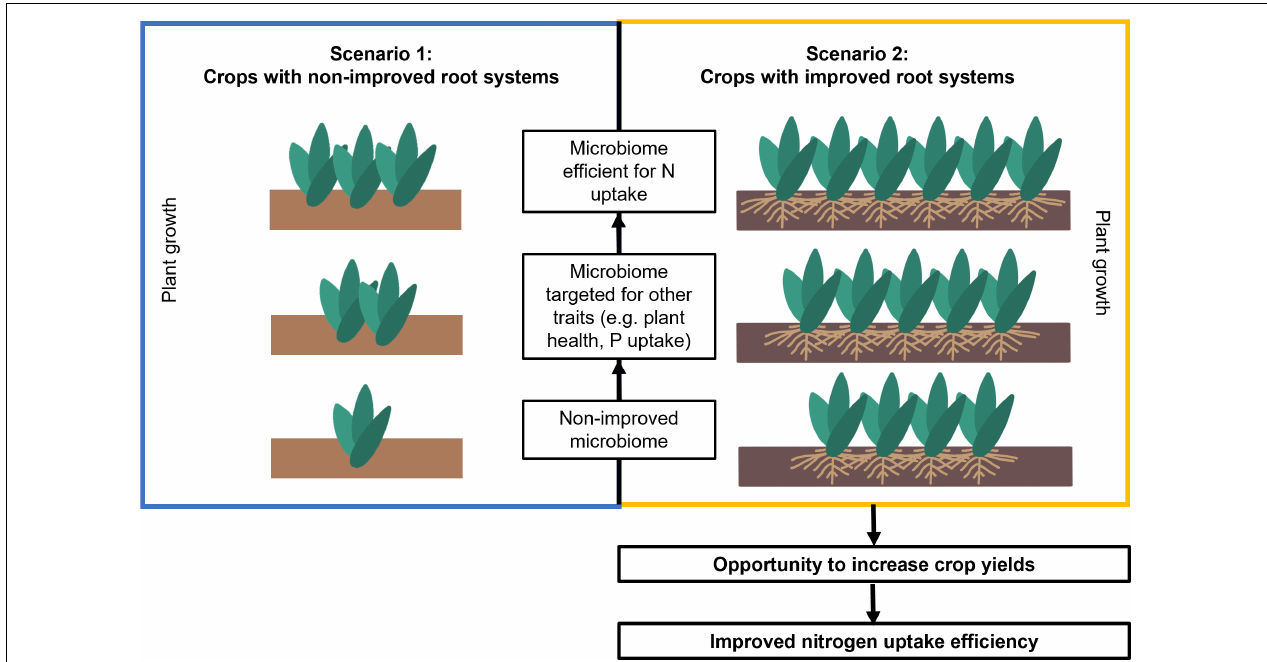
FIGURE 5 | Scenarios for root-microbiome engineering with and without including plant-breeding targeting root traits, using the example of N uptake as the most important abiotic stress in the location where breeding is occurring. The focus of the target in the plant breeding part have been detailed (only shoots in scenario 1, shoots and roots in scenario 2). We hypothesize the greatest margin of improvement might be obtained when root breeding and microbiome breeding are combined (shown here as the plant drawing with the most numerous individuals) compared to a basic margin of improvement with only one plant when neither of these two approaches are considered. Within each of the scenarios, narrowing the stressor factors to the most important one at the local level (low nitrogen in the example), is hypothesized to provide the best yields. The black arrows indicate the expected direction of yield increase if the different approaches are taken. It is assumed that root microbiomes have the potential to improve plant growth when applied in the field, but this assumption is still a matter of research and technological